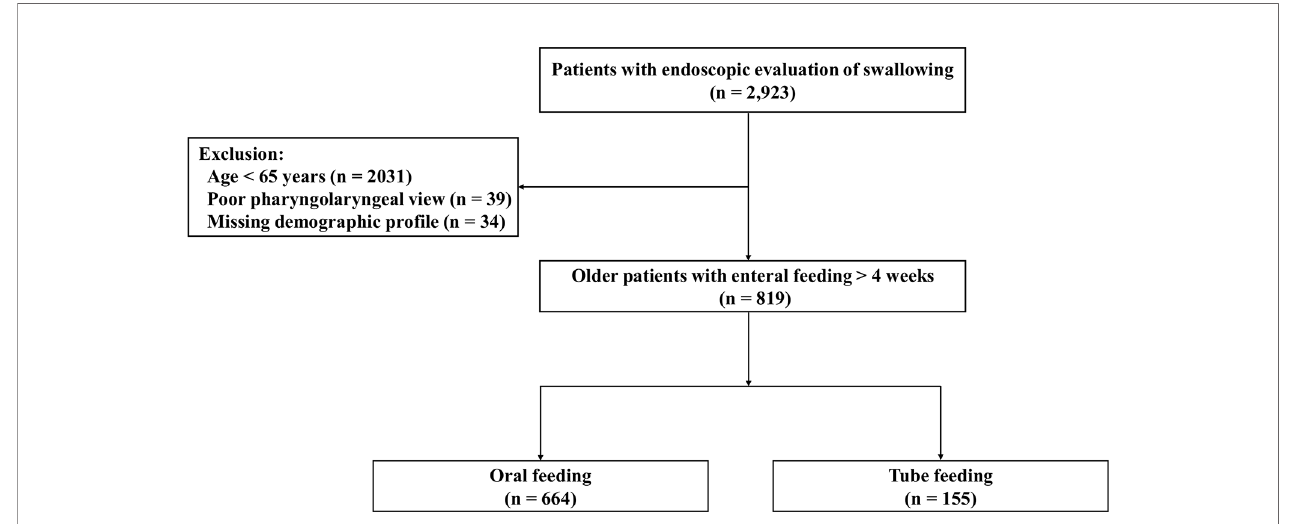
FIGURE 1 | Patient selection fl ow